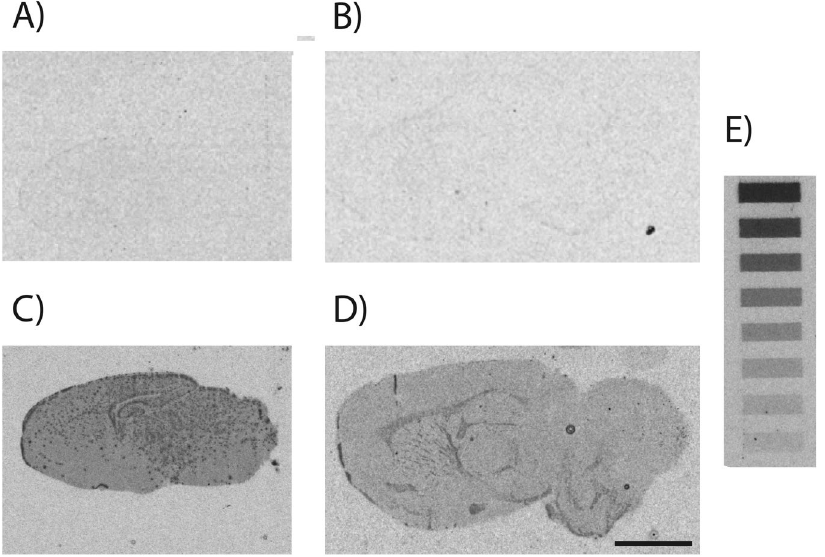
Figure 6. Autoradiographic images of rat brains. ( A ) Control P4, no radioactivity exposure. ( B ) adult exposed acutely to 30 μg/kg digoxin with 20 μCi 3 H-digoxin (negative control) ( C ) P4 exposed acutely to 15 mg/kg paracetamol with 2 μCi 3 H-paracetamol or ( D ) adult exposed acutely to 15 mg/kg paracetamol with 20 μCi 3 H-paracetamol. ( A ) Control and ( B ) digoxin brains show only background levels of radioactivity. In the adult brain ( D ) there was widespread distribution of paracetamol with accumulation in the corpus callosum and striatum white matter. The intensity of the image of the P4 brain ( C ) indicates widespread distribution and greater entry of paracetamol compared to adults (all films were exposed for the same length of time). Adult control showed only background exposure (not illustrated). Scale bar (5 mm) in bottom right applies to all brain sections. ( E ) Radioactive 3 H standards (Amersham, 3.1–35 ng/mg) were exposed on the same film as the brain